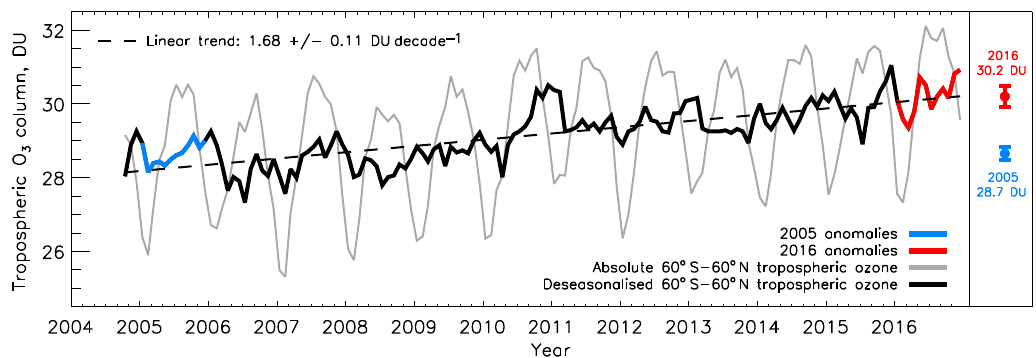
Figure 4. The 60 ◦ S–60 ◦ N total tropospheric column ozone between 2004 and 2016. OMI/MLS integrated ozone (grey line) and deseason- alised time series (black) are shown. The 2005 and 2016 periods are plotted in blue and red, respectively, and the mean and two standard errors on the mean for these two years are plotted on the right, with the mean value given alongside. The mean linear trend estimate (dashed line) and the 1 standard deviation uncertainty are also